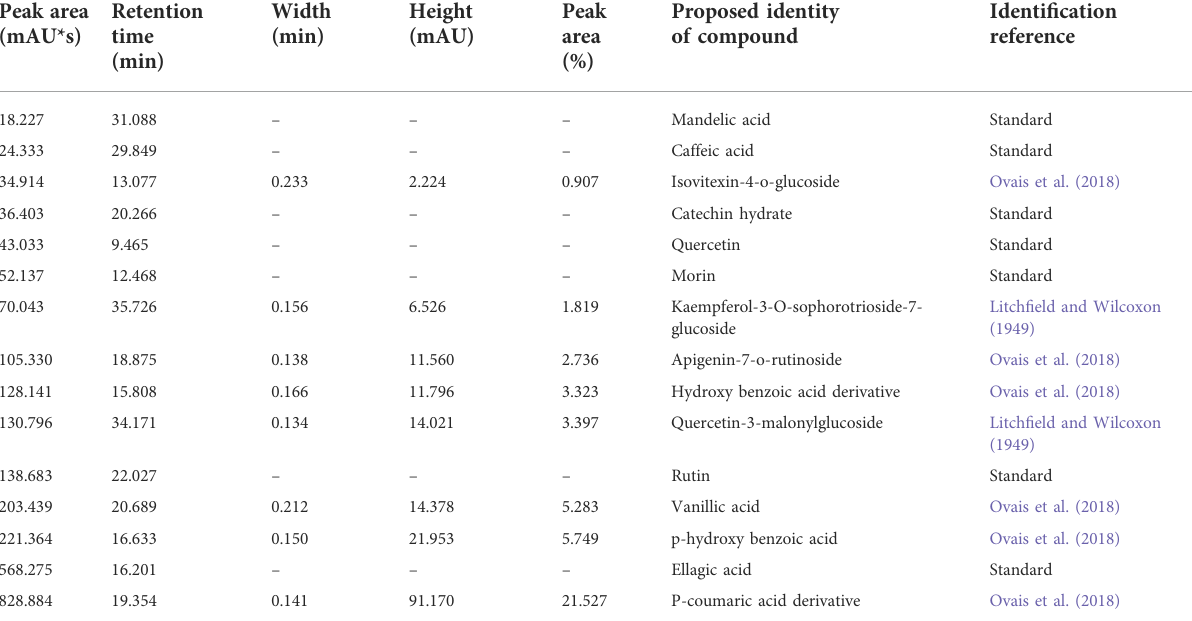
TABLE 3 Phenolic compounds identi fi ed in HPLC pro fi ling of P. gemini fl orum leaf extract. Peak area